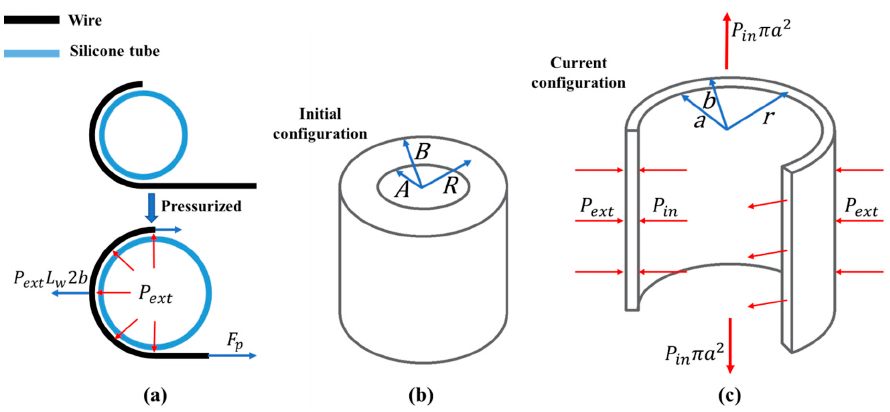
Figure 4. ( a ) For elucidation and force analysis, half of the wire is shown considering non-friction presumption. Sectional view of pipe before ( b ) and after ( c ) pressurized.